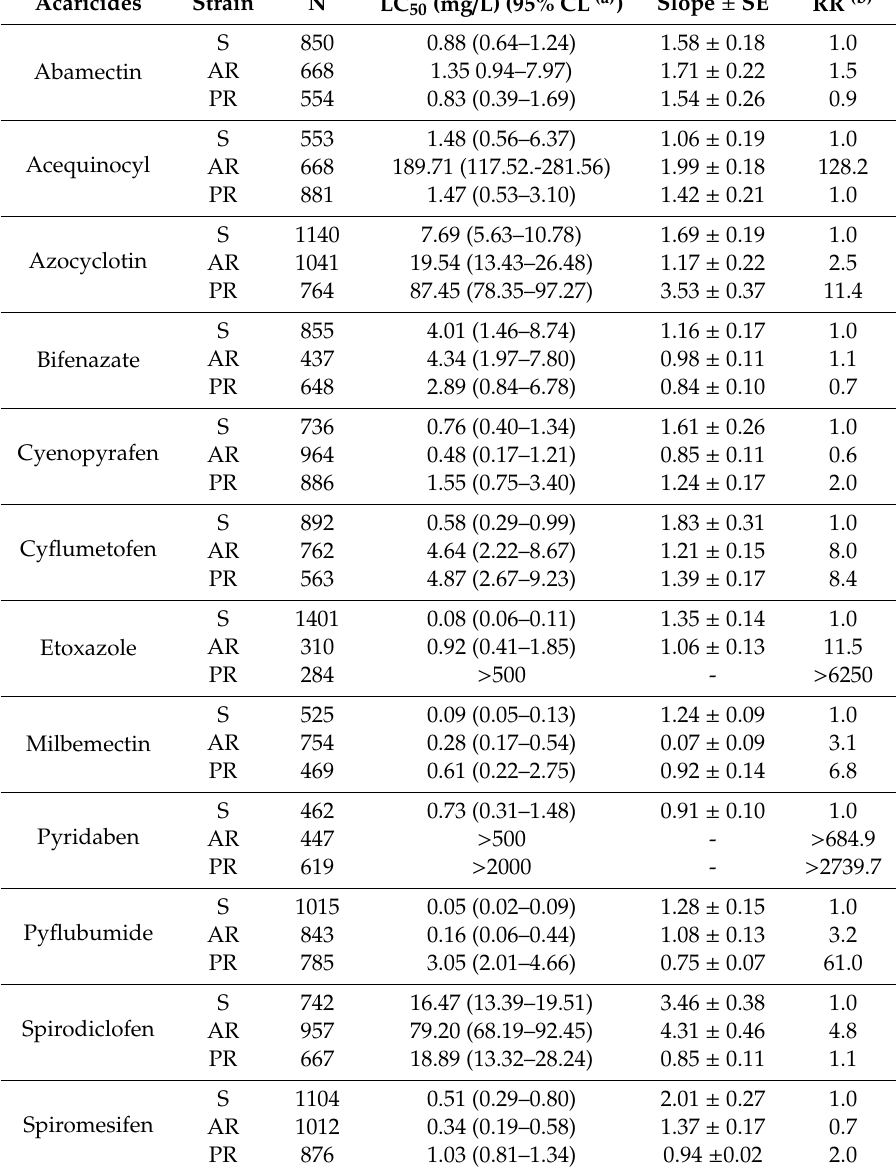
Table 3. Susceptibility to acaricides in the S, AR and PR strains of Tetranychus urticae eggs.